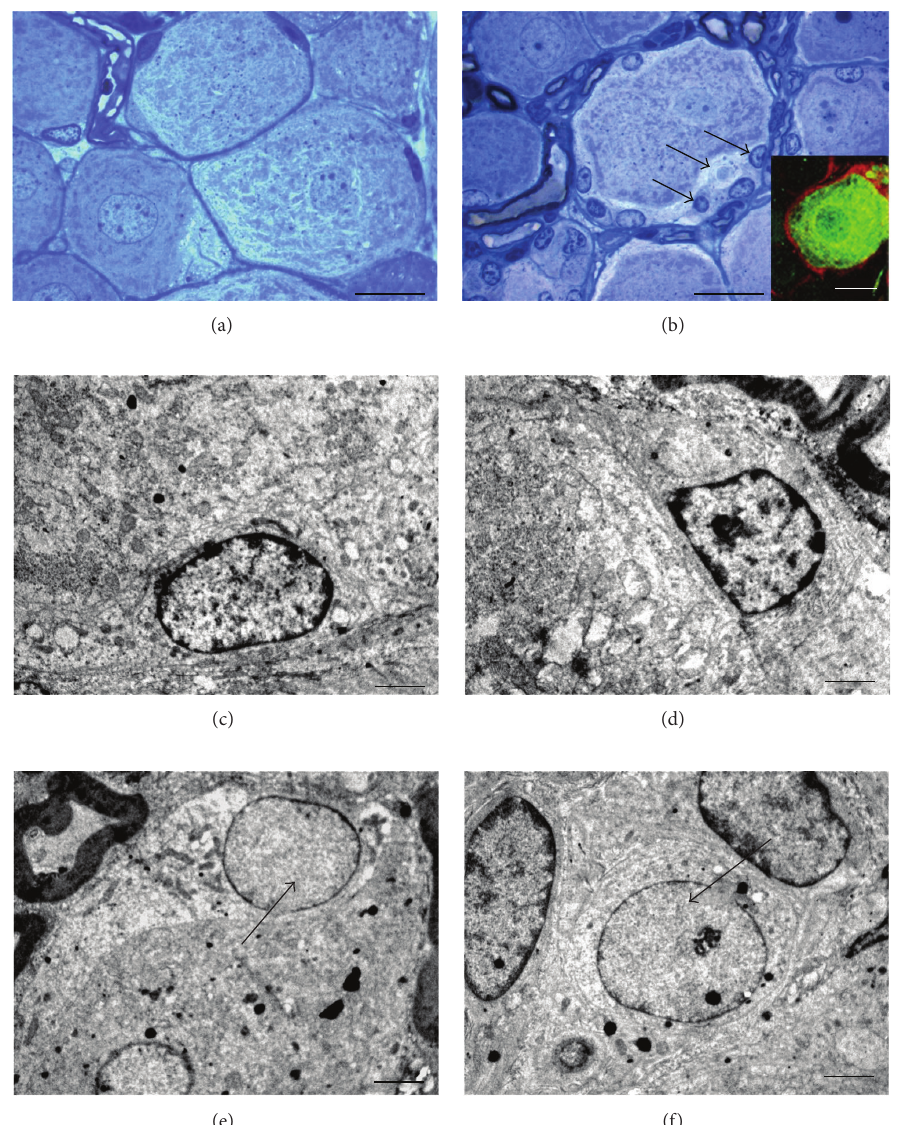
Figure 6: High magnification light microscopy pictures of toluidine blue stained semithin sections of controls (a) and DRG harvested 5 days after nerve crush lesion (b) in which many cells are seen surrounding neurons (b, arrows). A double fluorescence staining shows S100-positive cells(red)surroundinganeurofilament200 KDa-positive(green)neuron(boxinb).Theultrastructuralanalysisinelectronmicroscopyshows at low magnification morphological features of glial cells (c, d) and neuronal-like cells (e, f, arrows). Scale bars: a, b = 20 𝜇 m; c–f = 2 𝜇